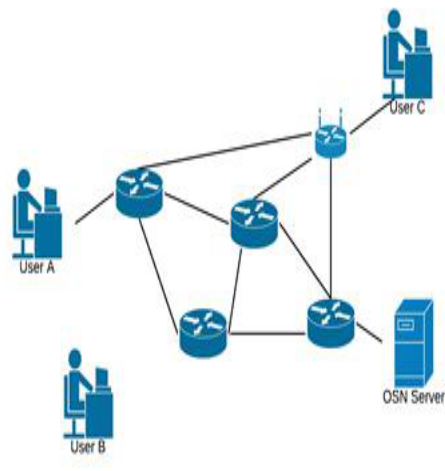
Figure 1 . Client- Server Architecture